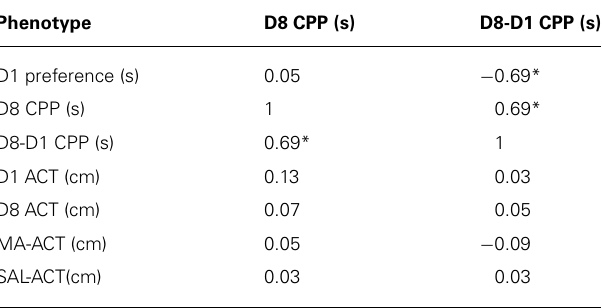
Table 1 | Correlation of MA-CPP with D1 preference and locomotor phenotypes inAIL